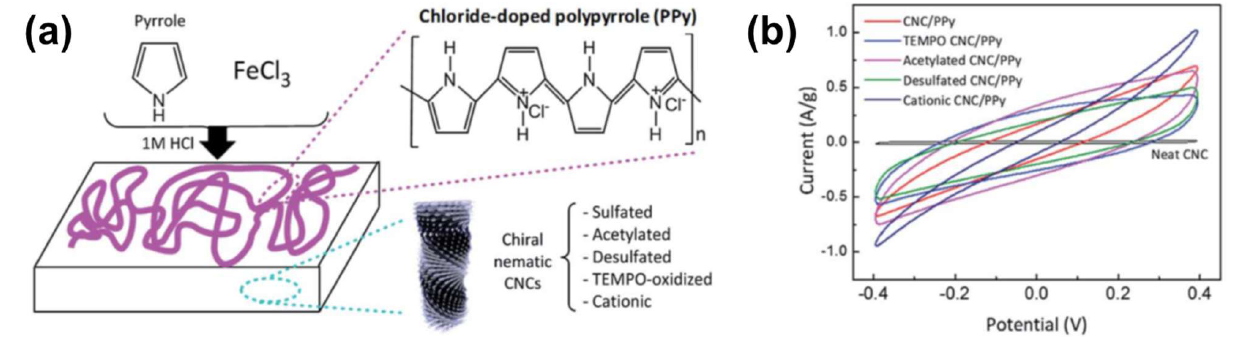
Figure 5. ( a ) Schematic for preparing cellulose nanocrystal (CNC)/polypyrrole (PPy) composite films. ( b ) Cyclic voltammograms of CNC/PPy composites, where the CNCs were subjected to various surface modifications (( a , b ) were reproduced from [69] by permission of Wiley). TEMPO, (2,2,6,6-tetramethylpiperidin-1-yl)oxyl.